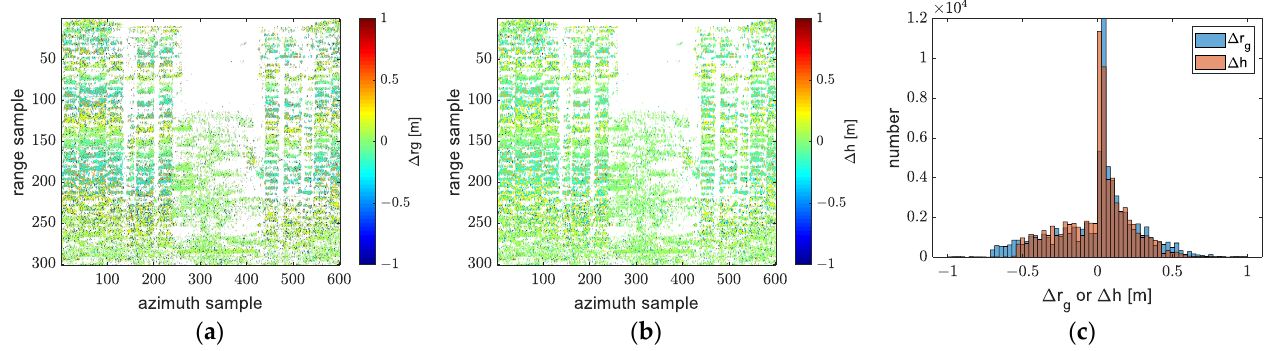
Figure 30. The ground range and height error between transformed model 4 and model 5: ( a ) the ground range error; ( b ) the height error; ( c ) a histogram of the ground range and height error.